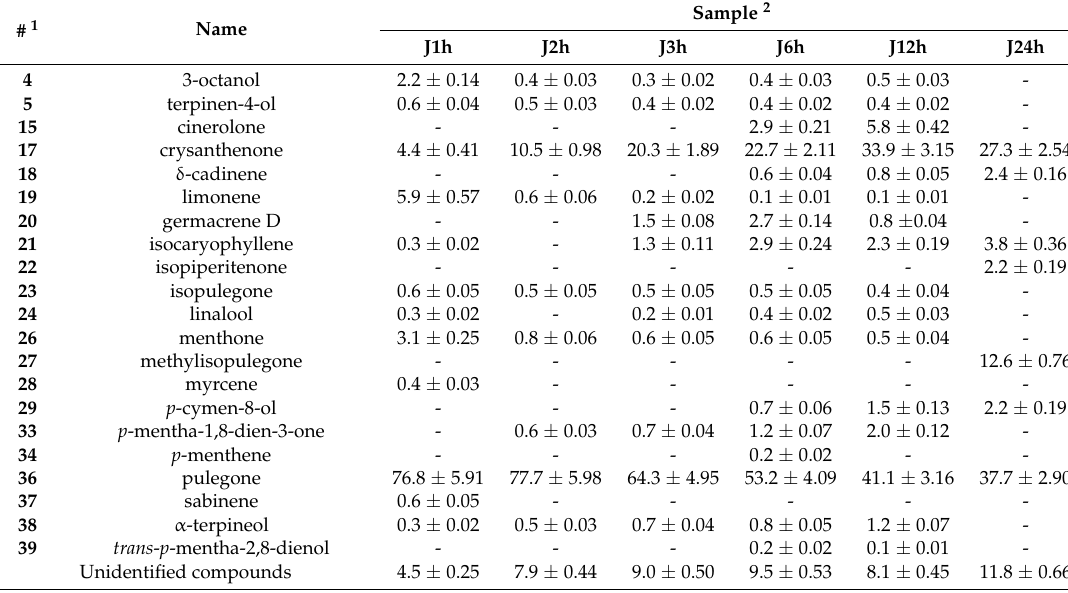
Table 2. Chemical composition (%) of TEOCG extracted in